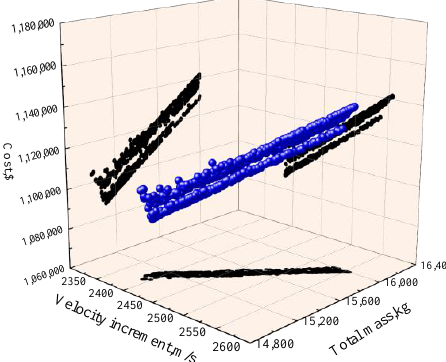
Figure 8. Pareto solution set of HRM-TGGF.